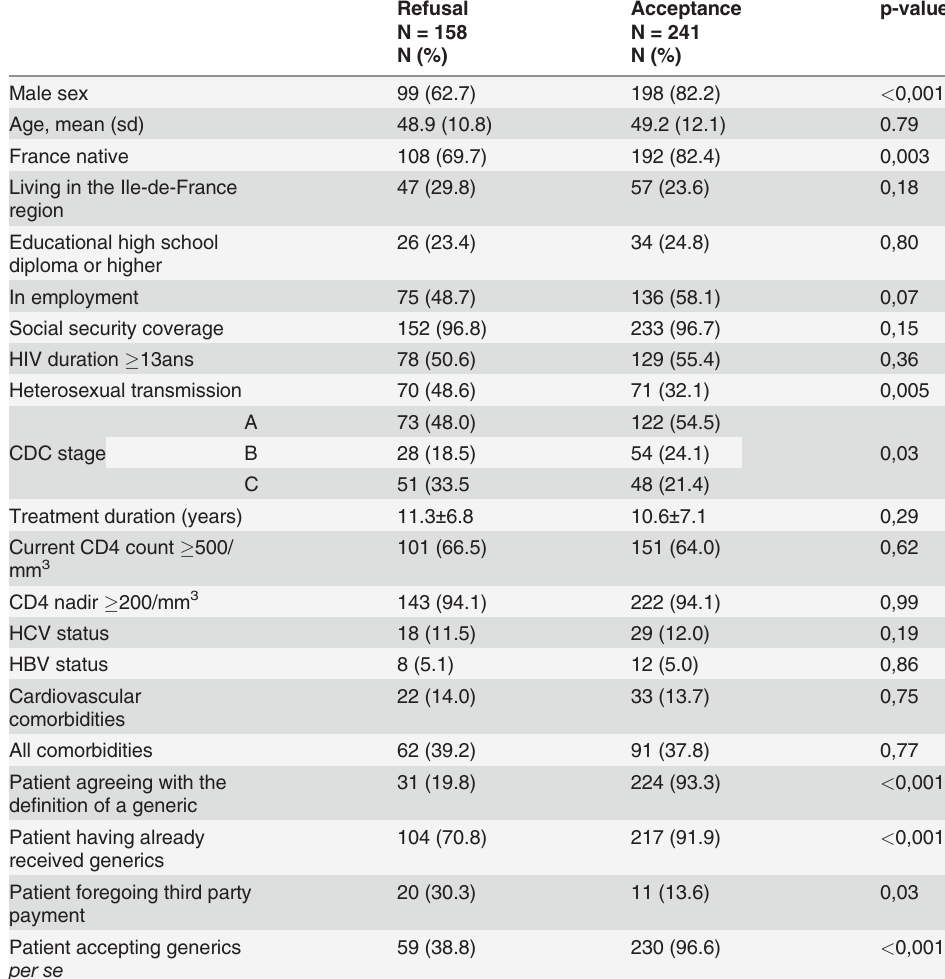
Table 3. Factors associated with acceptance of ARV generics by